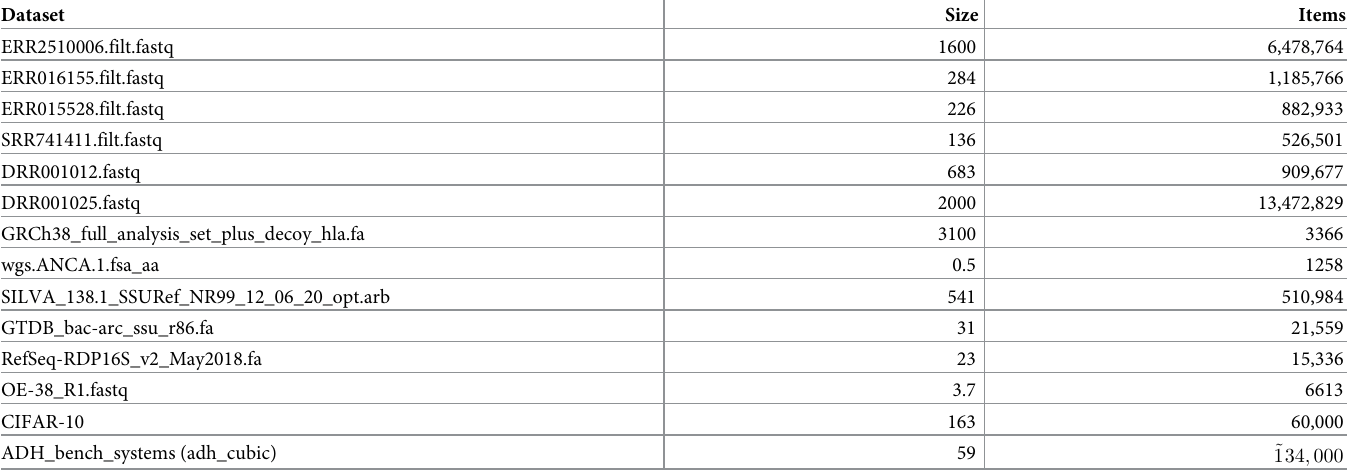
Table 3. BOOTABLE benchmark datasets with sizes in Megabytes and the number of sequences or images for CIFAR-10 or number of atoms for ADH in the Items column. Dataset Size Items